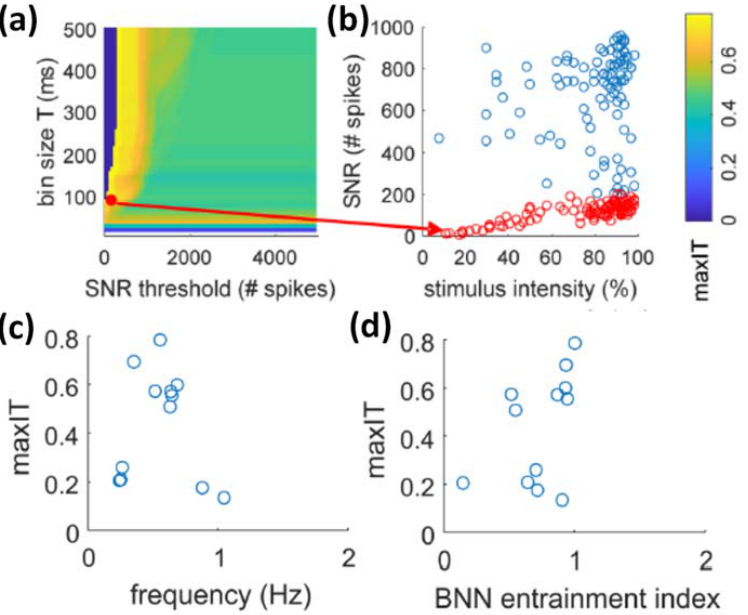
Figure 4. Information transmission from SNN to BNN. ( a ) Heatmap of the maxIT (maximum information transmission) as a function of the response bin size T and the threshold on the scalar network response (SNR). The SNR is the count of all spikes evoked in the BNN within the time T following the stimulus. The threshold on the SNR sets the maximum limit of the SNR over which responses would be discarded for the maxIT quantification. This is to discard overshooting re ‐ sponses linked to network synchronization dynamics and not directly due to the stimulus feature such as the intensity, as also shown in panel ( b ). ( b ) In the representative experiment, the maximal information transmission was obtained with T = 90 ms and for a threshold of 200 spikes (red dot in the heatmap of panel ( a ). In the plot of the SNR as a function of stimulus intensity, the responses below threshold are shown in red and display a linear trend. ( c ) The maximum information trans ‐ mission across all experiments is shown as a function of average stimulus frequency and entrain ‐ ment index of the BNN. ( d ) The BNN entrainment index was calculated as the ratio of evoked (i.e., following the stimulus) versus spontaneous (i.e., distant from the stimulation time) network syn ‐ chronizations. Adapted from [78]. Specifically, in optimal information transmission conditions, the spontaneous syn ‐ chronizations in the SNN (mimicking the ones present in the BNN) entrained the global synchronizations in the BNN through optical stimulations (Figure 5). Information trans ‐ mission could take place in linear responses (red dots in Figure 4b), which occurred in between the entrained (i.e., evoked) global synchronizations in the BNN (supra ‐ linear blue responses in Figure 4b).